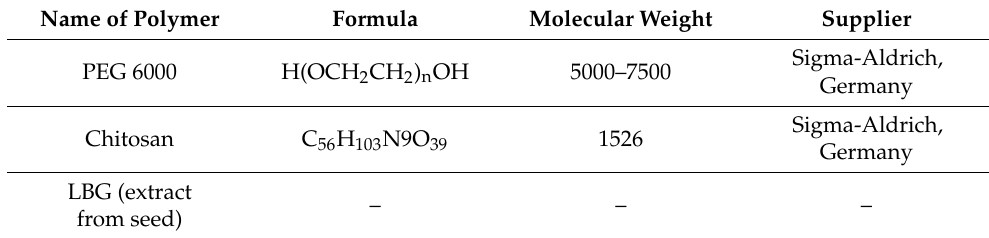
Table 7. Basic information about the polymers